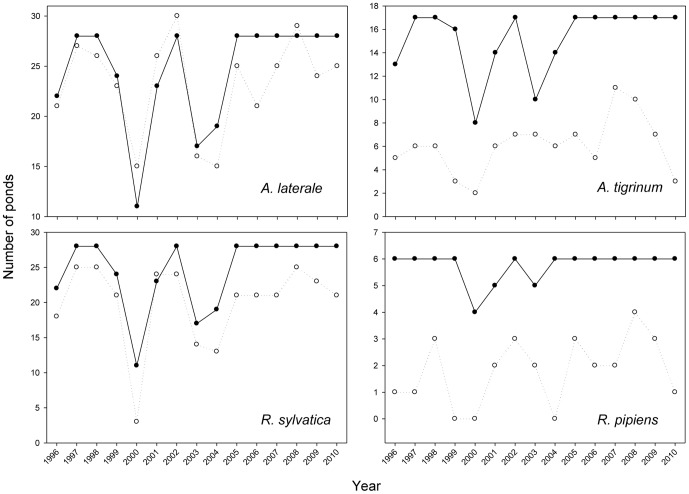
Temporal trends of ponds occupied (open symbols, dashed line) versus available (closed symbols, solid line).Comparisons for congeners from two families (Ambystoma and Rana) where one species was abundant (left column, i.e. on the flat portion of the constrained distribution-abundance curve) and one rare (right column, i.e. low on the curve).